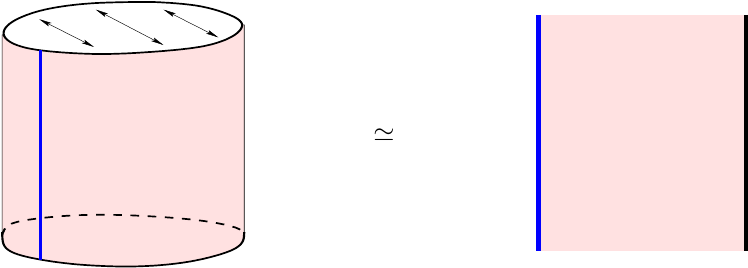
Figure 8 . A folding trick that leads to A-model interpretation of the equivariant Verlinde formula. The Hilbert space of a 2d theory M on a circle with a line defect (interface) B is equivalent to a 2d theory M (cid:2) M on a strip with the \diagonal" (totally re(cid:13)ective) boundary condition at one end and B at the